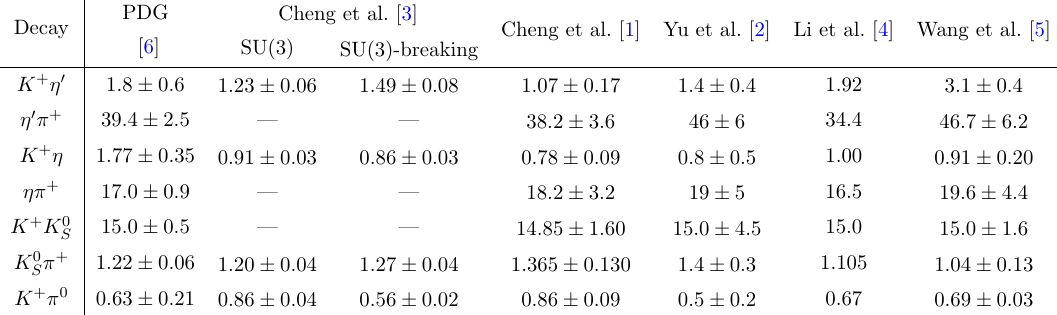
D + D (cid:3)(cid:0) + c.c. ! (cid:13)D + D (cid:0) based on data samples collected at the center-of-mass energies s s s s p s = 4.178, 4.189, 4.199, 4.209, 4.219 and 4.226 GeV, corresponding to the integrated luminosities of 3189.0, 526.7, 526.0, 517.1, 514.6 and 1091.7 pb (cid:0) 1 , respectively [13,